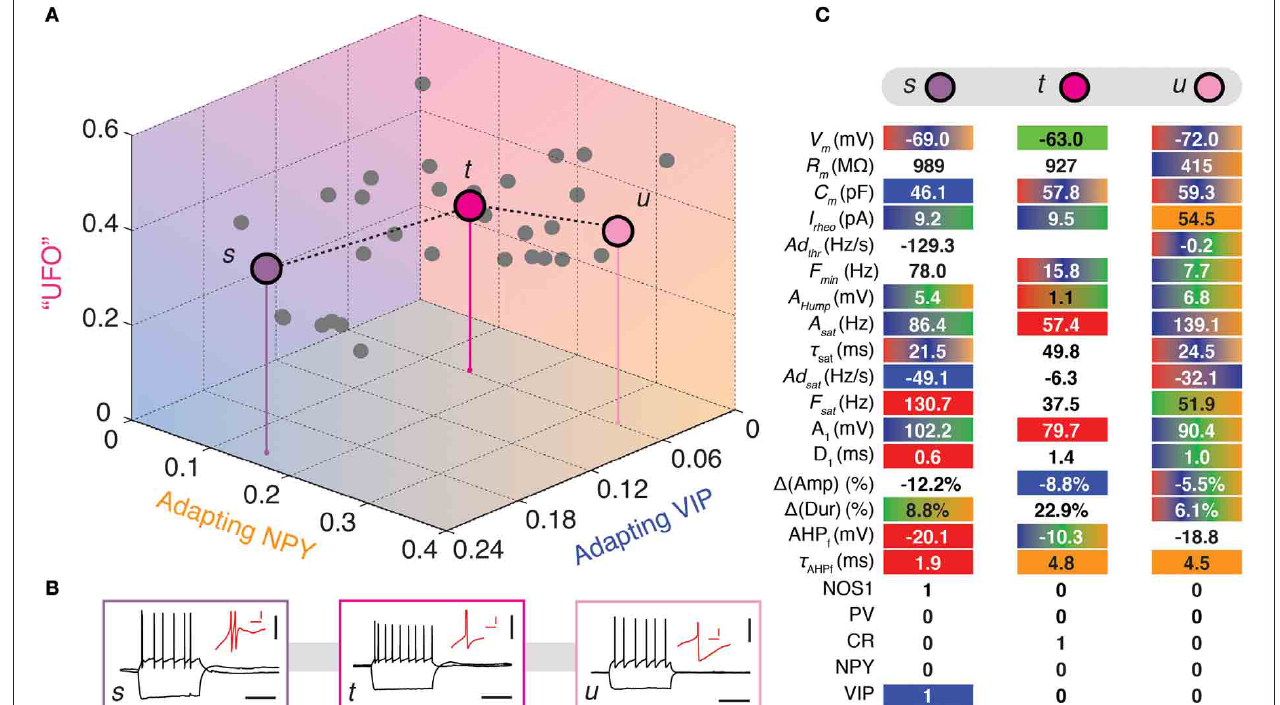
FIGURE 5 | Visiting the UFOs. (A) Tridimensional representation joining three heterogeneous UFOs. Adapting VIP (blue), Adapting NPY (orange), and UFOs (pink) archetypes. Individual neurons are depicted as dots in a 3D space of memberships. The X, Y, and Z axes correspond to memberships to the Adapting VIP, Adapting NPY, and UFOs archetypes, respectively. Vertical stems denoting the projection of selected cells on the bidimensional base plane are introduced as depth clues. (B) Current-clamp recordings of illustrative transition neurons (cells s to u colored in panel A ) in response to